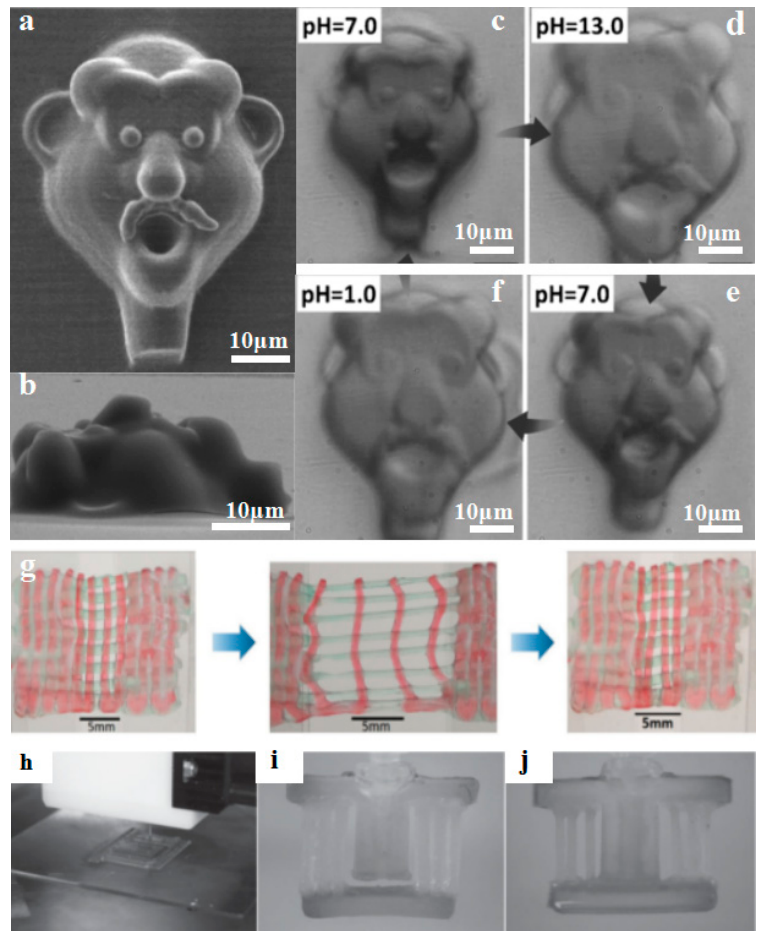
Figure 8. Shape-shifting proteins and hydrogels fabricated by 4D printing ( a , b ) A microscale face fabricated by femtosecond laser direct writing (FsLDW) of protein ( c , e ) the printed face changed in shape due to stimulation of pH (Scale bar 10 μ m), reprinted from [89] with the permission of John Wiley and Sons, Copyright 2011; ( g ) 4D-printed microscale shape memory hydrogels recovered from stretching, reprinted from [91] with the permission of John Wiley and Sons, Copyright 2015; ( h , j ) 4D-printed shape-shifting hydrogels for micro actuating, reprinted from [92] with the permission of John Wiley and Sons, Copyright 2015.